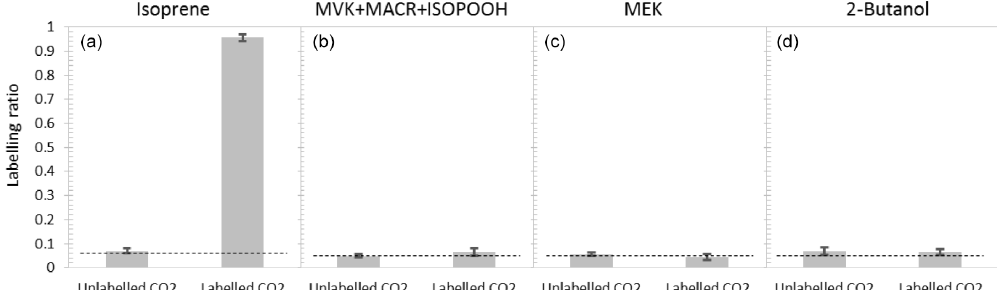
Figure 4. Emission of isoprene (a) , MVK + MACR + ISOPOOH (b) , MEK (c) , and 2-butanol (d) in red oak plants heat stressed at 45 ◦ C for 2h in the light, under 12 CO 2 or 13 CO 2 atmosphere. Dashed horizontal lines represent natural abundances of isotopic compounds.